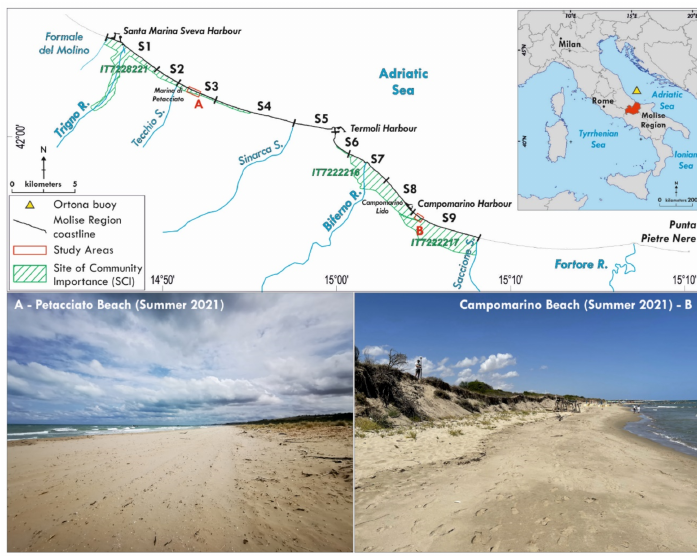
Figure 1. The Molise coast. Location and panoramic views of the two study areas, A and B. The Termoli promontory divides the Molise coast into two nearly independent sectors (physiographic sub-units) [21]. These sectors, hereinafter named the northern and southern Molise coasts, are oriented in the WNW and NW-SE directions,